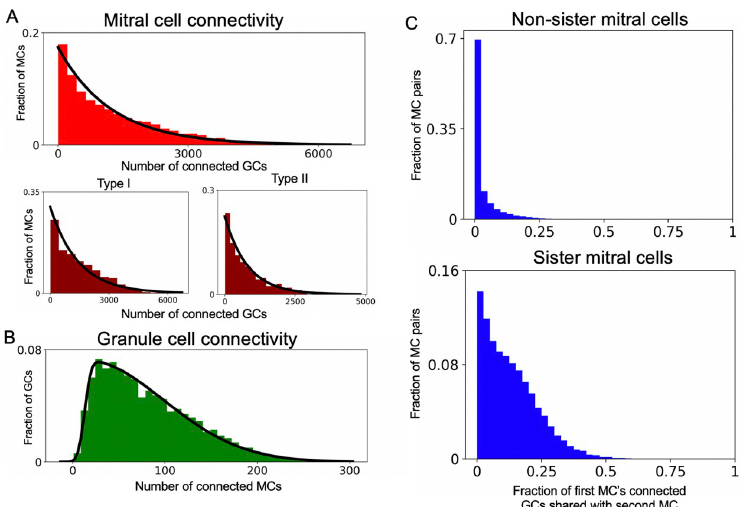
Fig 3. Network connectivity. (A) Top: Distribution of MCs by number of connected GCs, black line = exponential fit (mean 1225.8). Bottom: Distribution of type I (left) and II (right) MCs by number of connected GCs. Black line for type I MCs = exponential fit (mean 1426.0). Black line for type II MCs = exponential fit (mean 818.7). (B) Distribution of GCs by number of connected MCs. Black line = skewed normal fit (parameters α = 15.2, ξ = 13.0, ω = 85.5; see Methods for definition of skewed normal) (C) Distribution of fraction of connected GCs shared with another MC for non-sister (top) and sister (bottom) MCs.